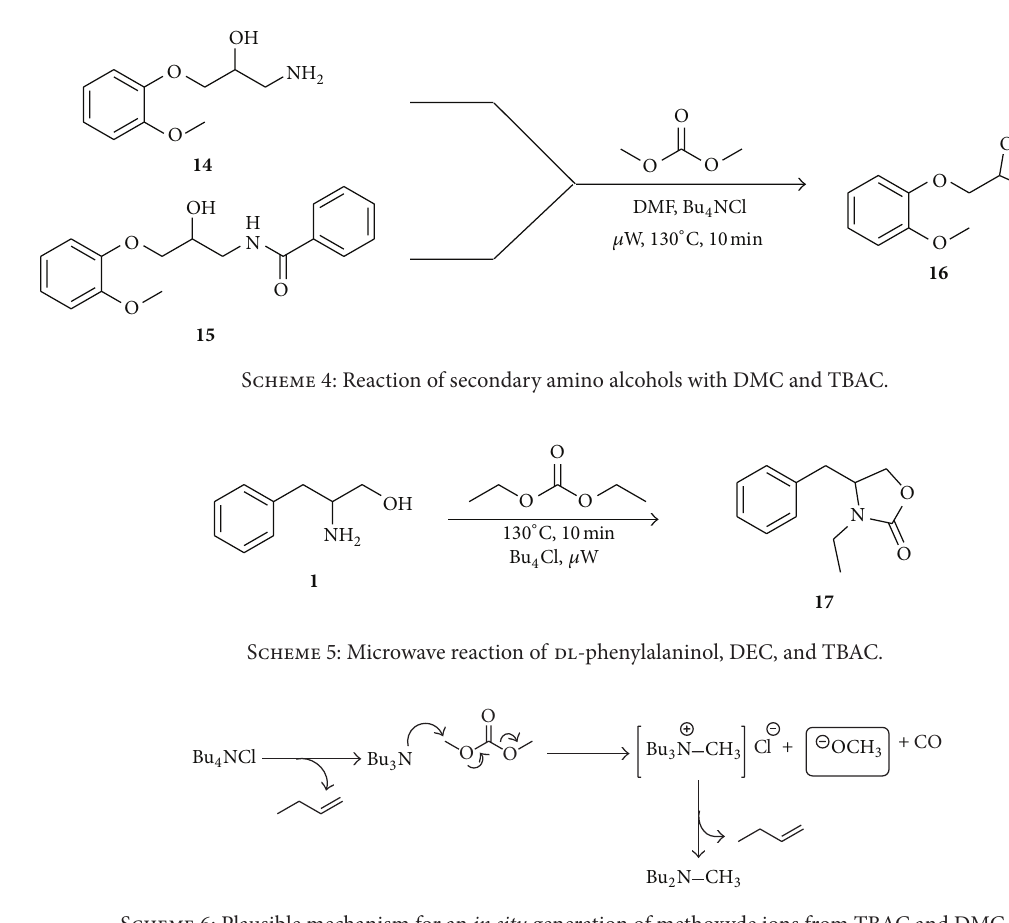
Scheme 6: Plausible mechanism for an in situ generation of methoxyde ions from TBAC and